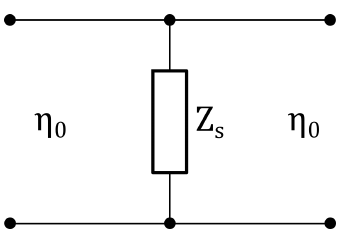
Figure 5. Tranmission-line equivalent circuit of an MTS layer, presented by surface sheet impedance Z s , placed in free space, and excited by a normally-incident